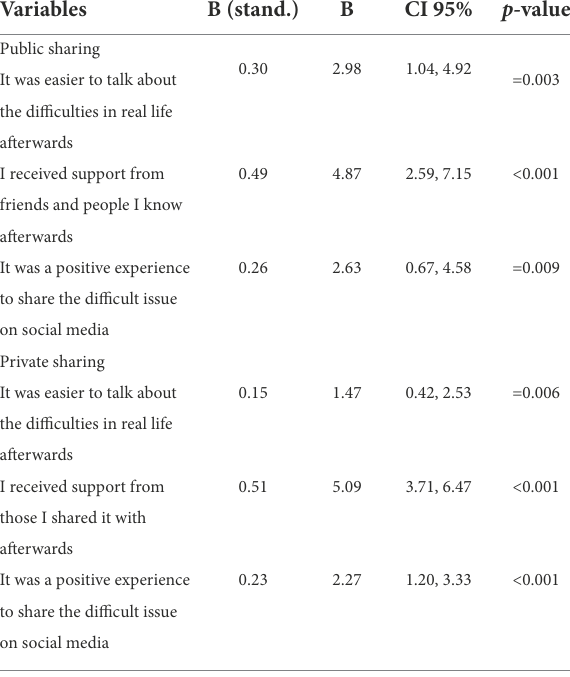
TABLE 4 Results from bivariate linear regression analyses for public and private sharing and the related social support